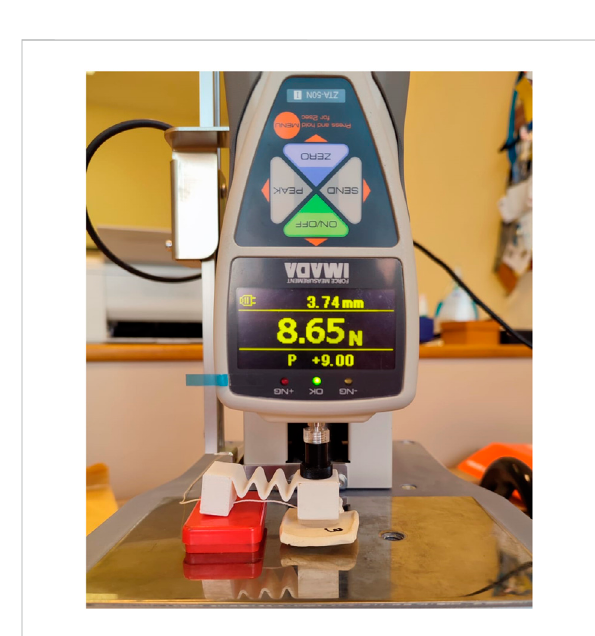
FIGURE 5 Displacement measurements.